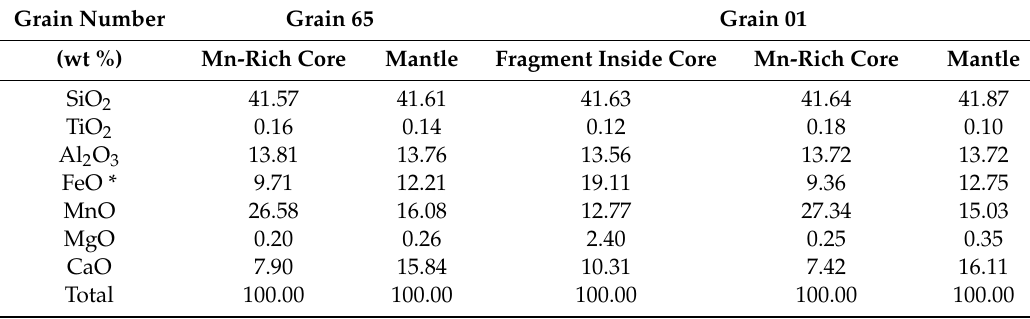
Table 1. Representative chemical composition of garnet analyzed semi-quantitatively by energy-dispersive X-ray spectroscopy (EDS). Automatically normalized to make the total